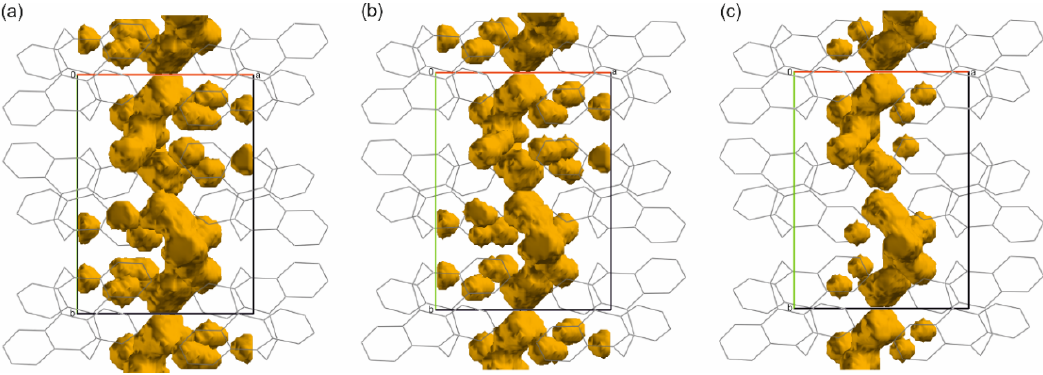
Figure 2. Molecules and voids in the crystal of ( 1 ) at ( a ) 0.1 MPa, ( b ) 0.3 GPa and ( c ) 1.0 GPa. The data for the preparation of part ( a ) were taken from [5]. The voids were calculated by means of Mercury 3.9 [26] with the probe radius 0.6 Å and grid 0.2 Å.